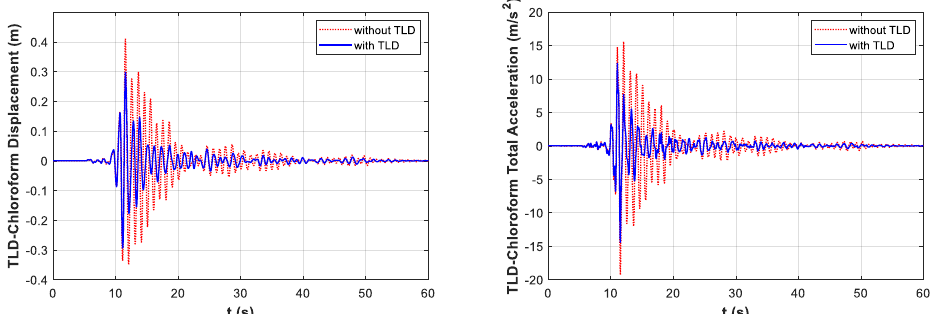
Figure 11. AHS optimization of the 10-story structure displacement – time and total acceleration – time graphs in the DUZCE/BOL090 earthquake record for TLD – seawater.